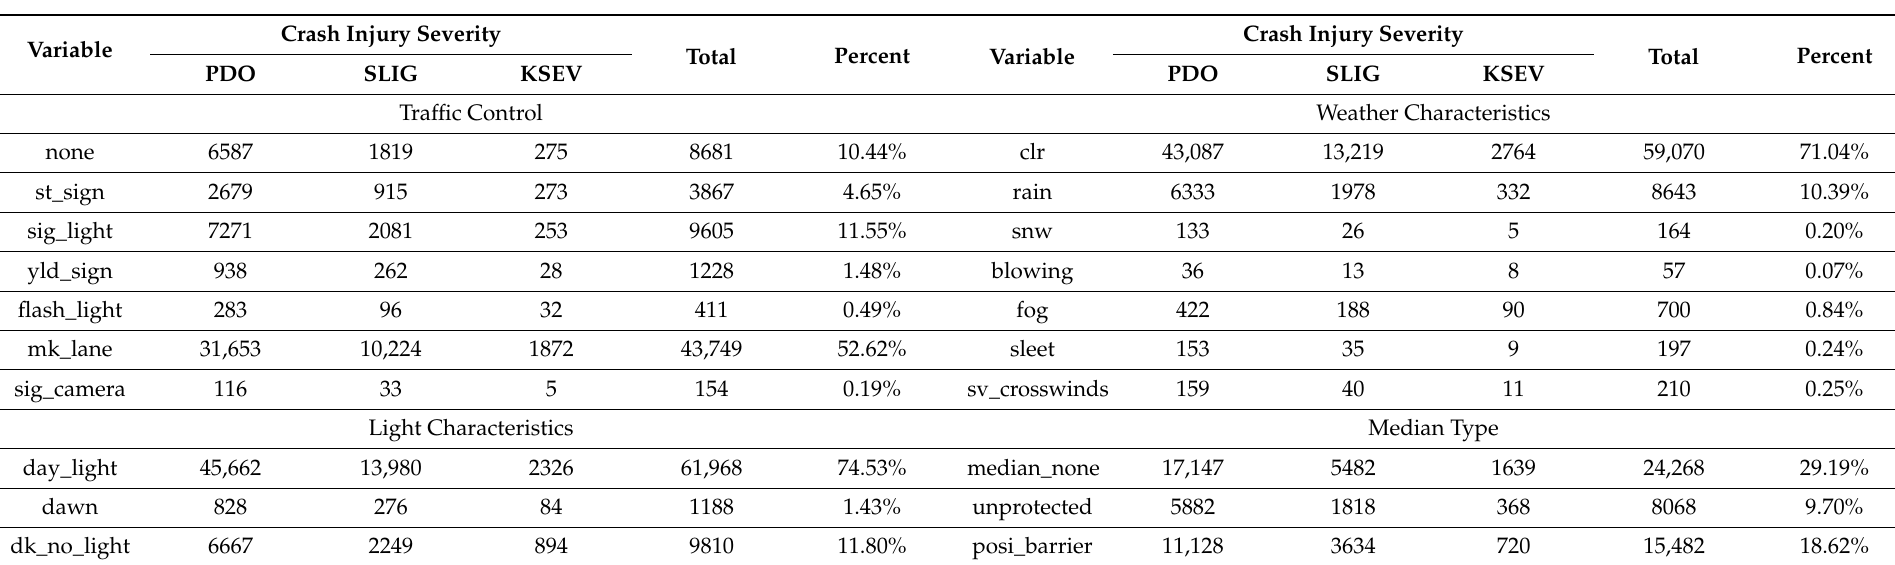
Table 2. Distribution of the